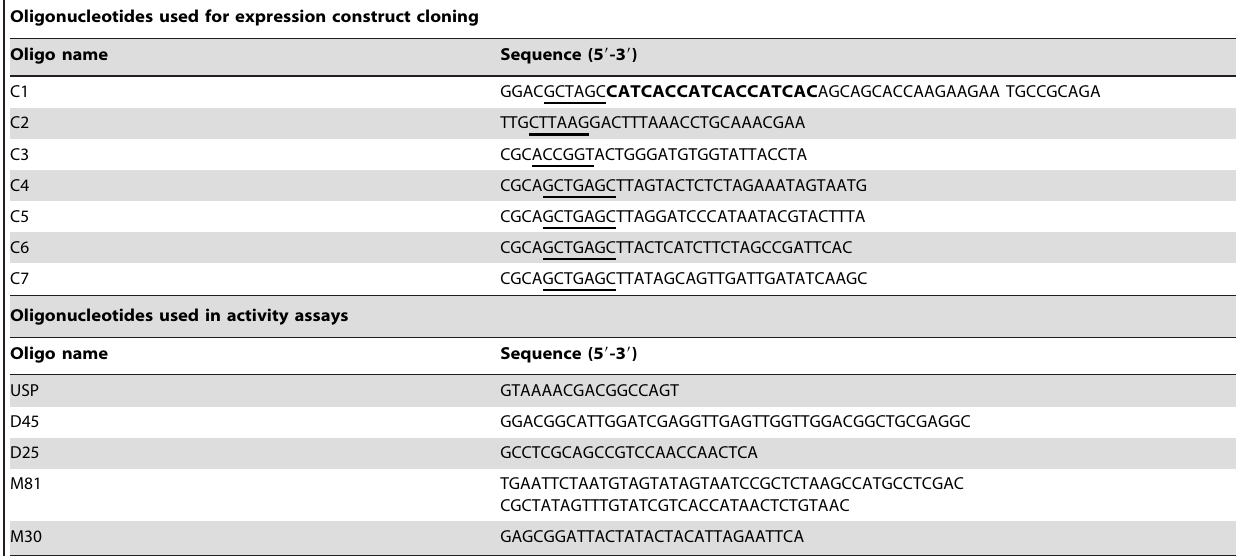
Table 1. DNA oligonucleotide